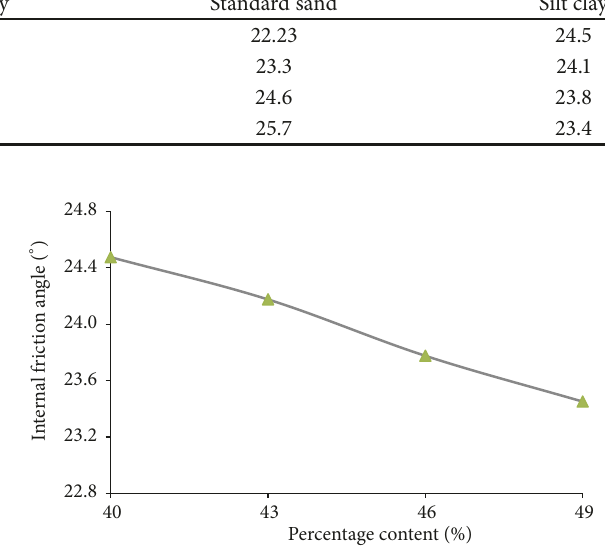
Figure 9: Influence of silt clay on the internal friction angle.